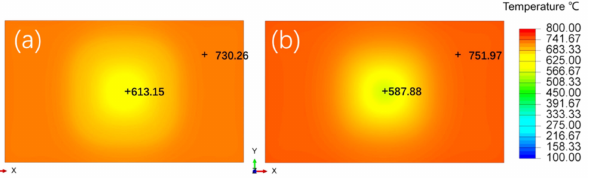
Figure 23. The simulated temperature distribution of the blank after tempering. ( a ) TPP-S; ( b )